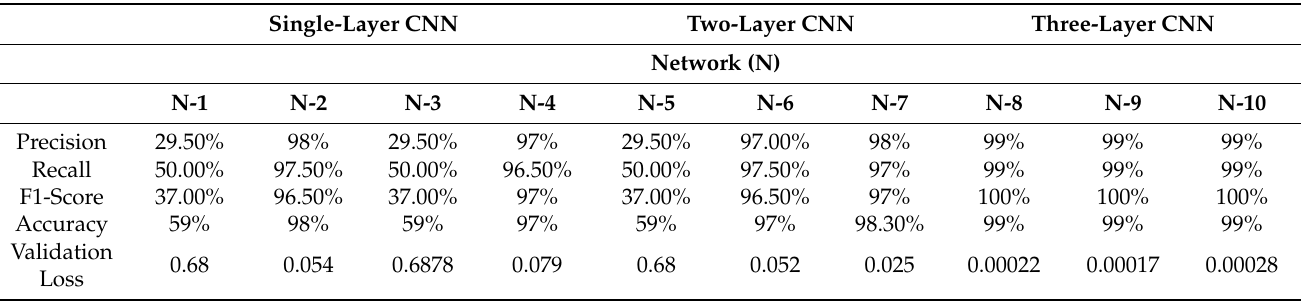
Table 5. Results of the multi (12)-lead ECG for the single-, two-, and three-convolutional layer